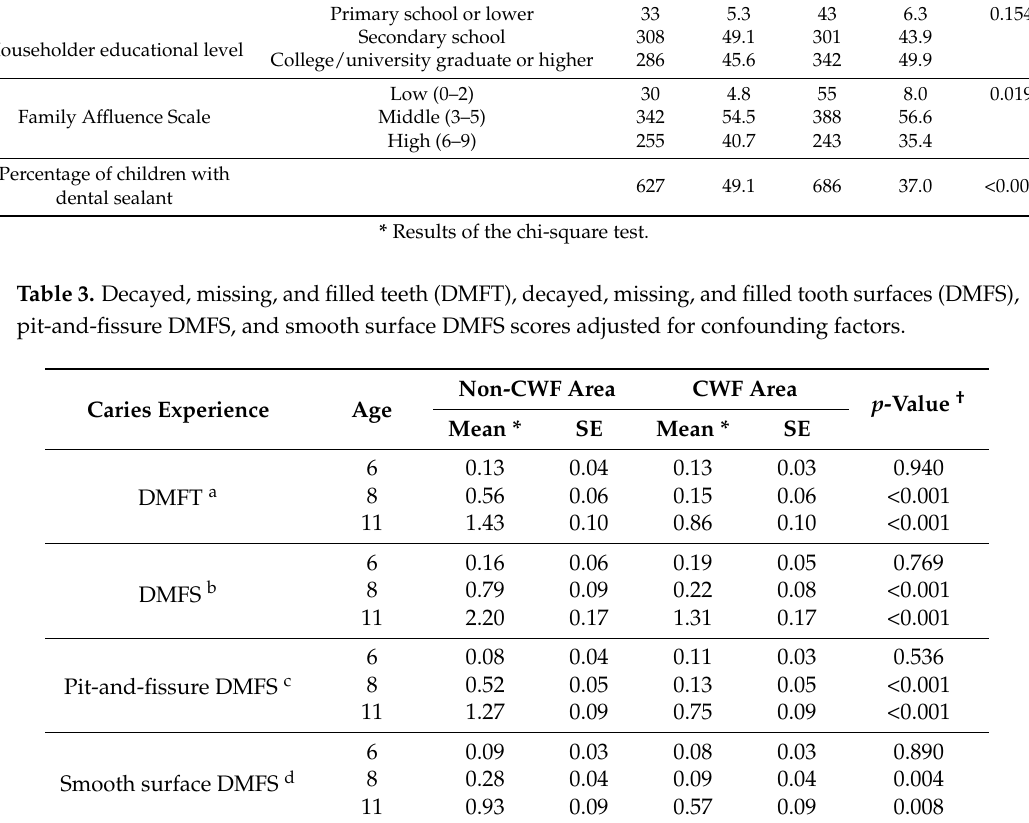
Table 2. Characteristics and oral health status of the participants.